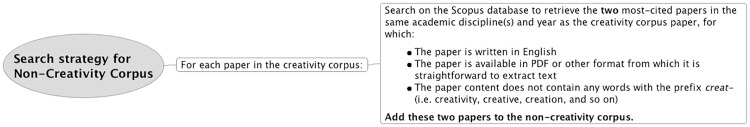
A flow diagram describing the search strategy used to identify papers for the non-creativity corpus.